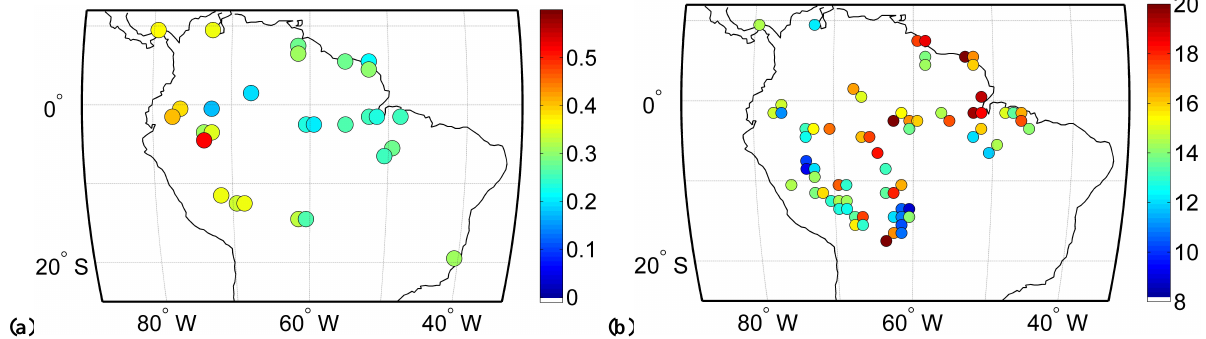
Fig. 6. (a) Estimated wood net primary productivity (NPP w [kg-Cm − 2 yr − 1 ]) and (b) wood live above-ground biomass (AGB w [kg-Cm − 2 ]), based on field data by Malhi et al. (2004) and (2006), respectively. Dots represent the average from measurement plots averaged to 1 ◦ × 1 ◦ grid